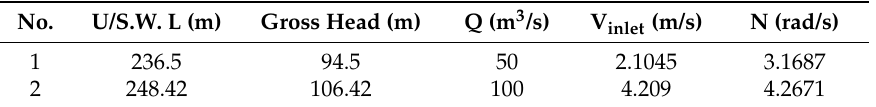
Table 3. Hydraulic calculations for the Temenggor turbine including up-stream water level (U/S.W. L), the flowrate (Q), the velocity (V) and the rotational speed of turbine runner (N). No. U/S.W. L (m) Gross Head (m) Q (m 3 /s) V inlet (m/s) N (rad/s)